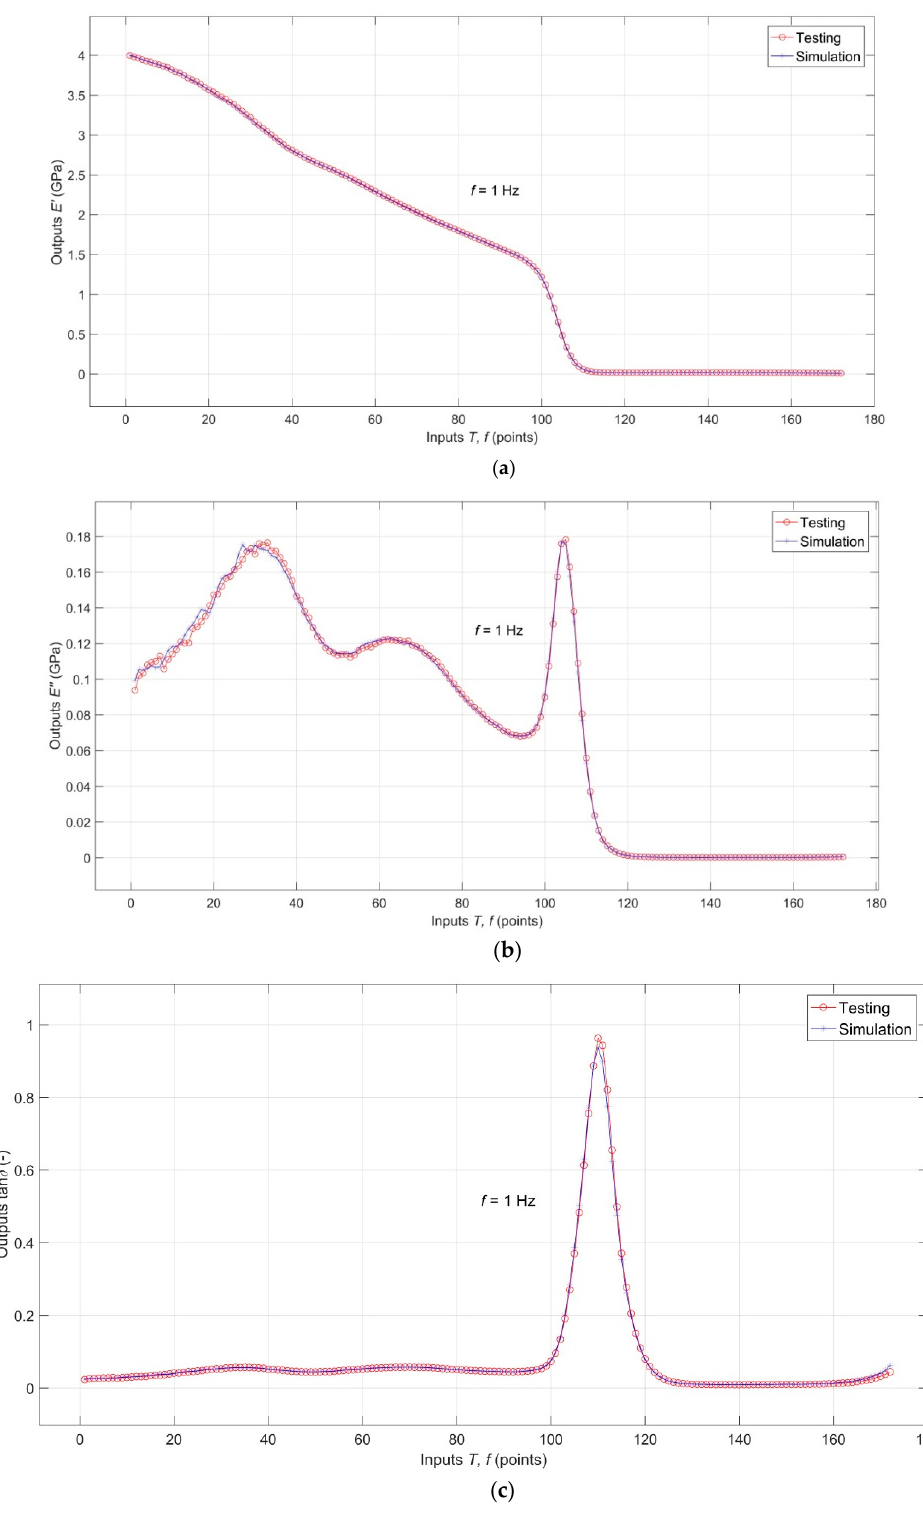
Figure 7. ( a ) Comparison of the testing targets with testing outputs for E ′ ( T, f ); ( b ) Comparison of the testing targets with testing outputs for E’’ ( T , f ); ( c ) Comparison of the testing targets with testing outputs for tan δ ( T , f ).